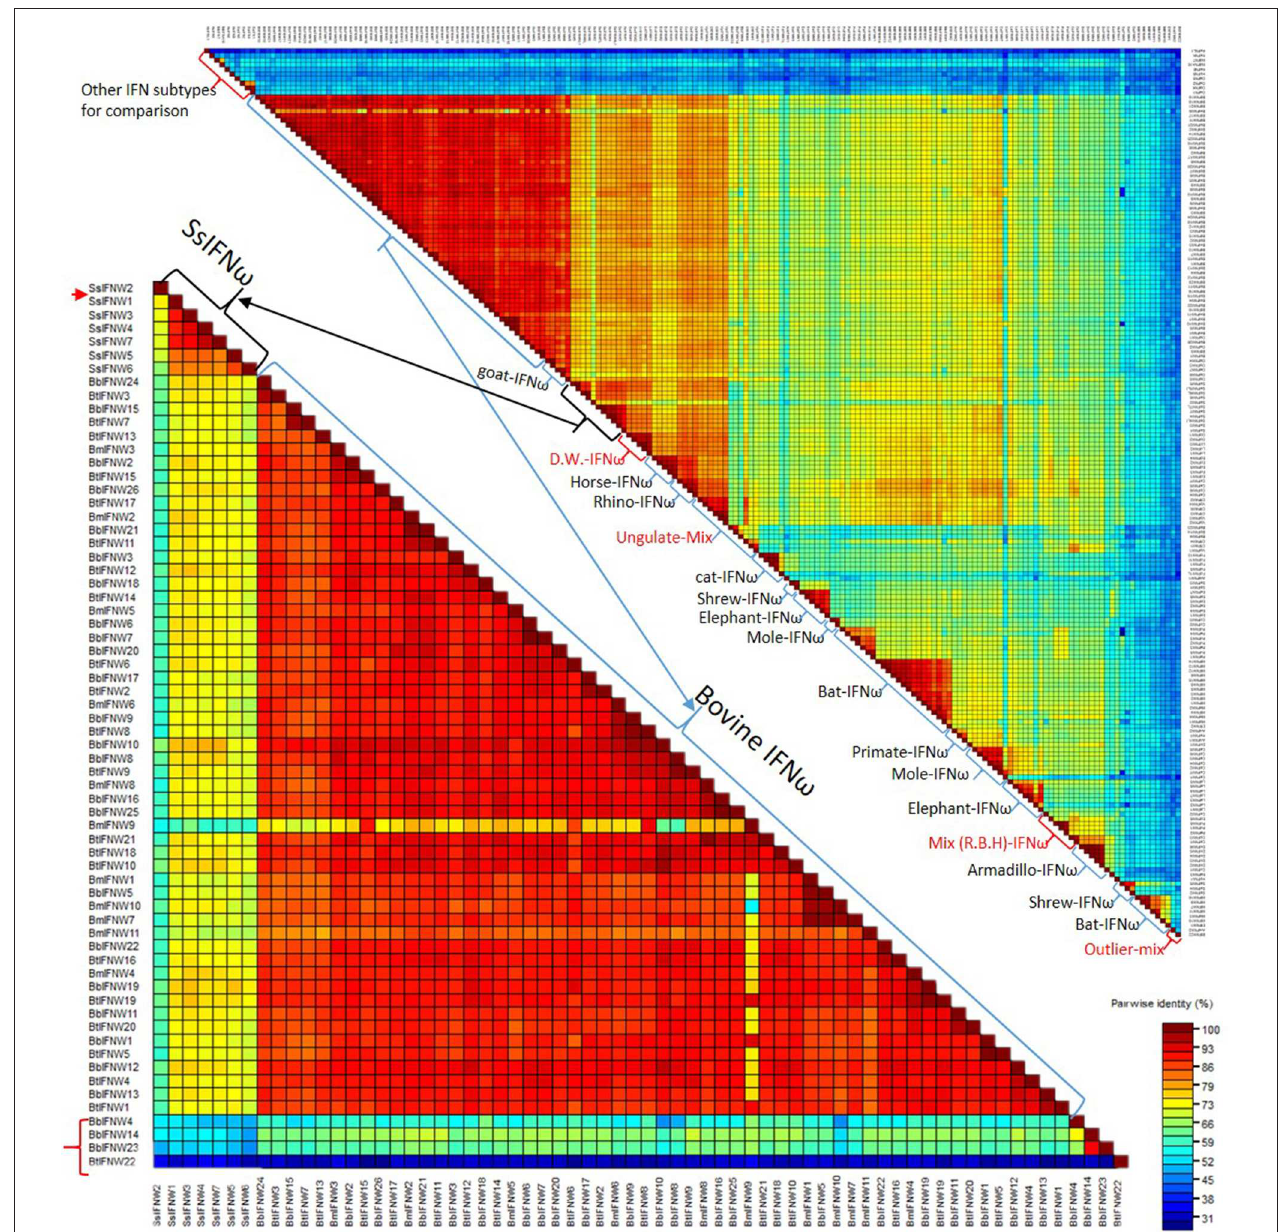
FIGURE 4 | Pairwise identity (%) plots among protein sequences of IFN- ω orthologs. Comparison and plot drawing were performed using a SDT program. IFN- ω molecules from individual Order or Genus might share a common progenitor, as also shown in the Figure 2 for the clustered phylogenic clades that share > 86% of identity. It was also common to observe that IFN- ω molecule from a species is phylogenically closer to the orthologs from other species of the same Family/Genus than those from the same species. For the mammalian genus/species that have multiple genes of IFN- ω subtype, we observed that IFN- ω peptides such as in bats, moles, shrews and elephants are formed into two major sub-clusters ( Upper ); however, it is primarily only one sub-cluster (with one to several “outliers,” labeled with red arrow or brackets) such as in swine and bovine species ( Bottom ). In addition, several clusters of IFN- ω peptides contain IFN- ω peptides from animals of different Genus/Family, such as that of the ungulate-mix (Alpaca, Camel, and Bioson) and the RBH-mix (Rhino, Bat, and Horse) clusters ( Upper ). RBH: R. Rhino, B. Bat, and H, horse; and other Species name abbreviations are first letters from the Latin names listed in the Supplemental Excel Sheet according to NCBI Taxonomy at http:// www.ncbi.nlm.nih.gov/Taxonomy (2, 8–10).